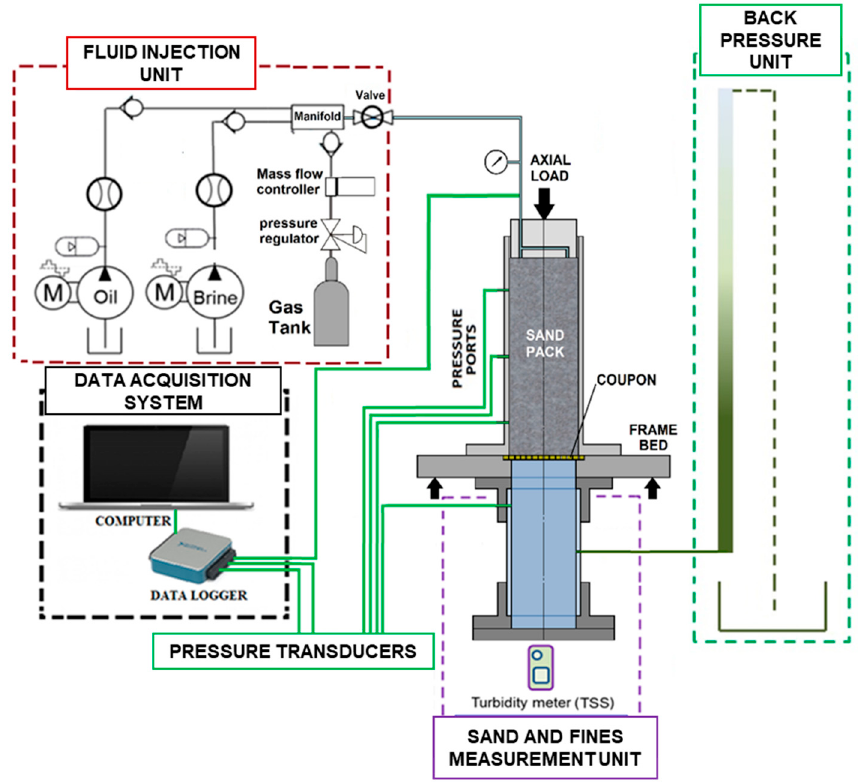
Figure 3. Improved testing facility schematic. Energies 2020 , 13 , x FOR PEER REVIEW